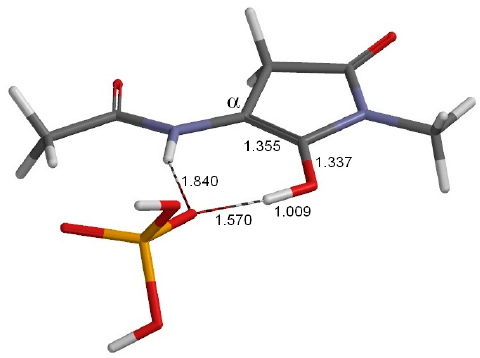
Figure 8. The geometry of the third transition state TS3 ( φ = − 169°, ψ = − 177°, χ 1 = 177°). This transition state connects EN2 (Figure 7) and its mirror-image geometry (EN2-MI). Selected interatomic distances are shown in Å. The imaginary frequency of this transition state is 18i cm − 1 . Grey: carbon; white: hydrogen; blue: nitrogen; red: oxygen; orange: phosphorus.